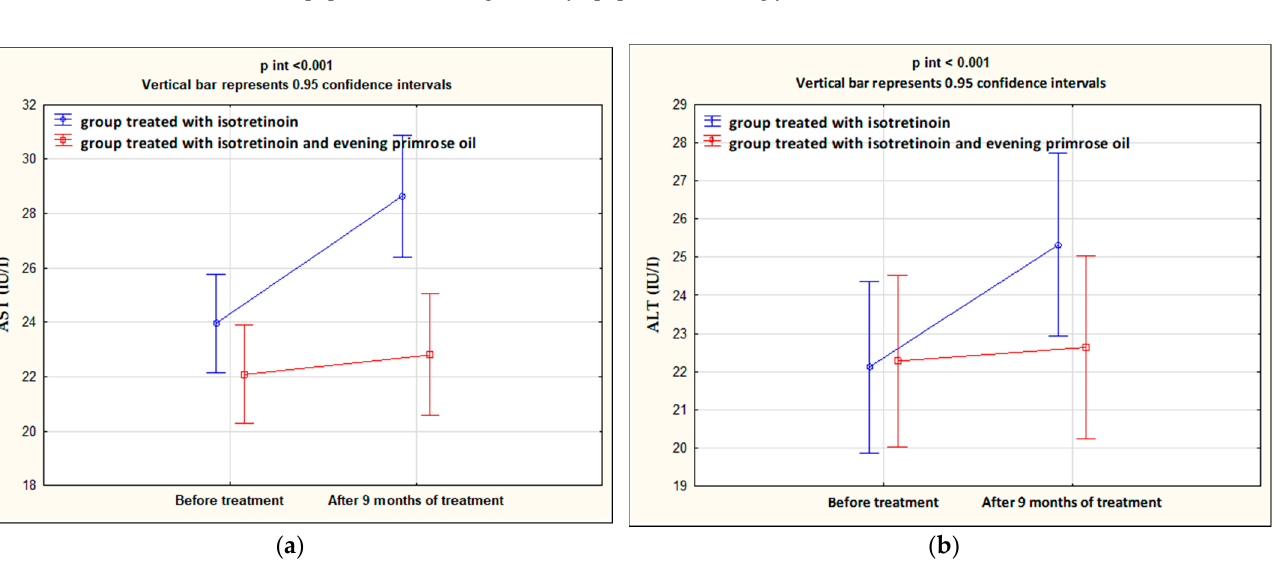
Figure 2. Changes in AST ( a ) and ALT ( b ) levels in the groups treated with isotretinoin or isotretinoin and evening primrose oil.